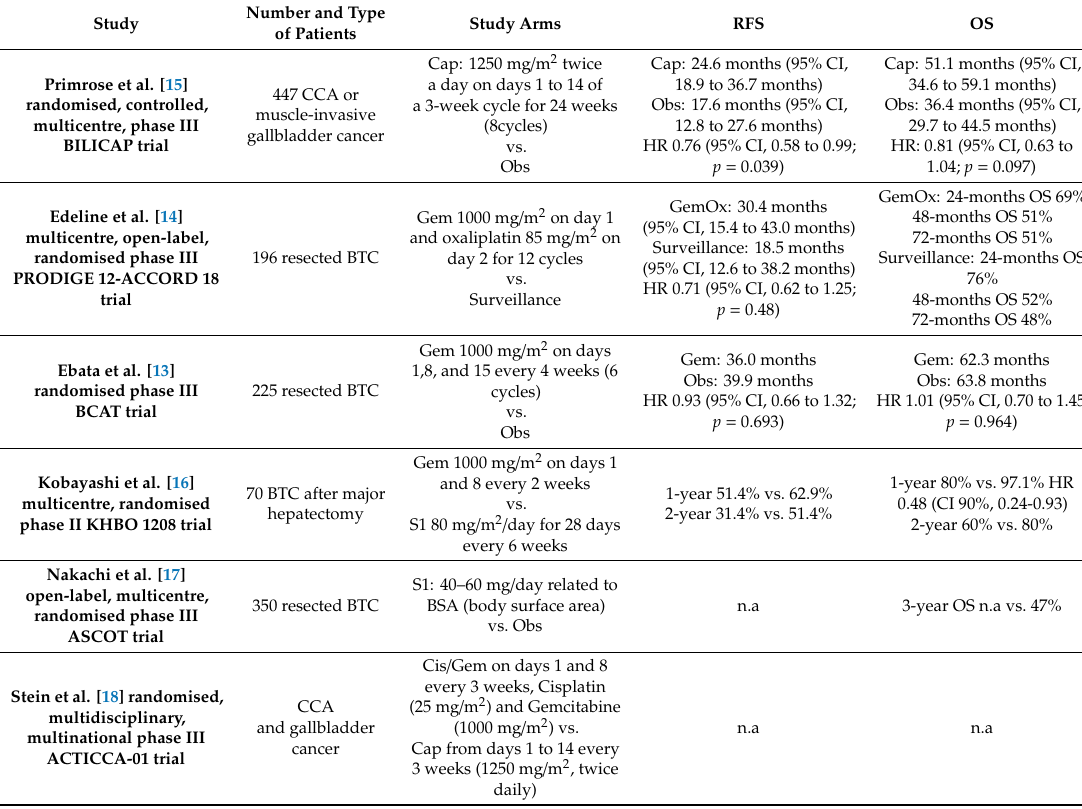
Table 1. Summary of adjuvant